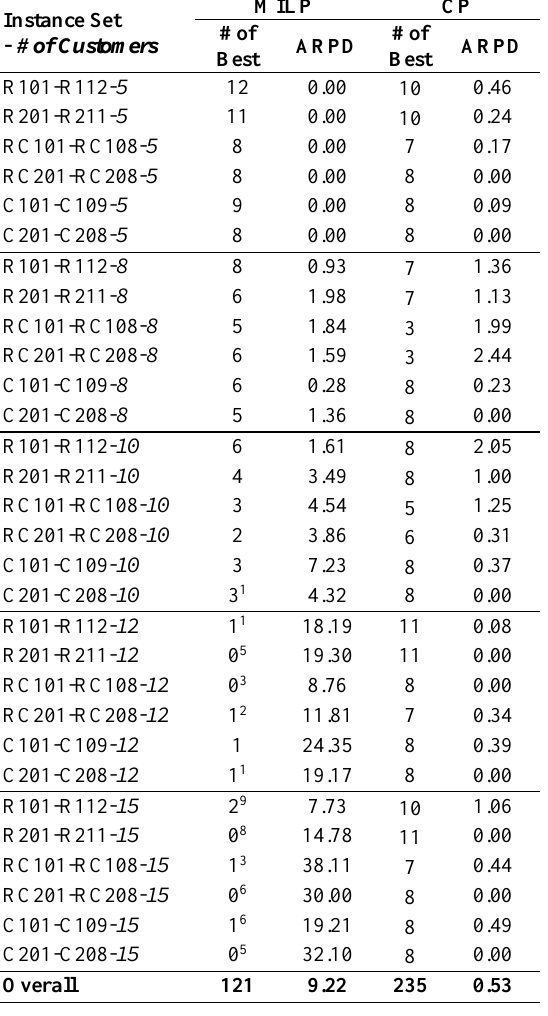
Table 1. The results for the MILP and CP models under 30 minutes time